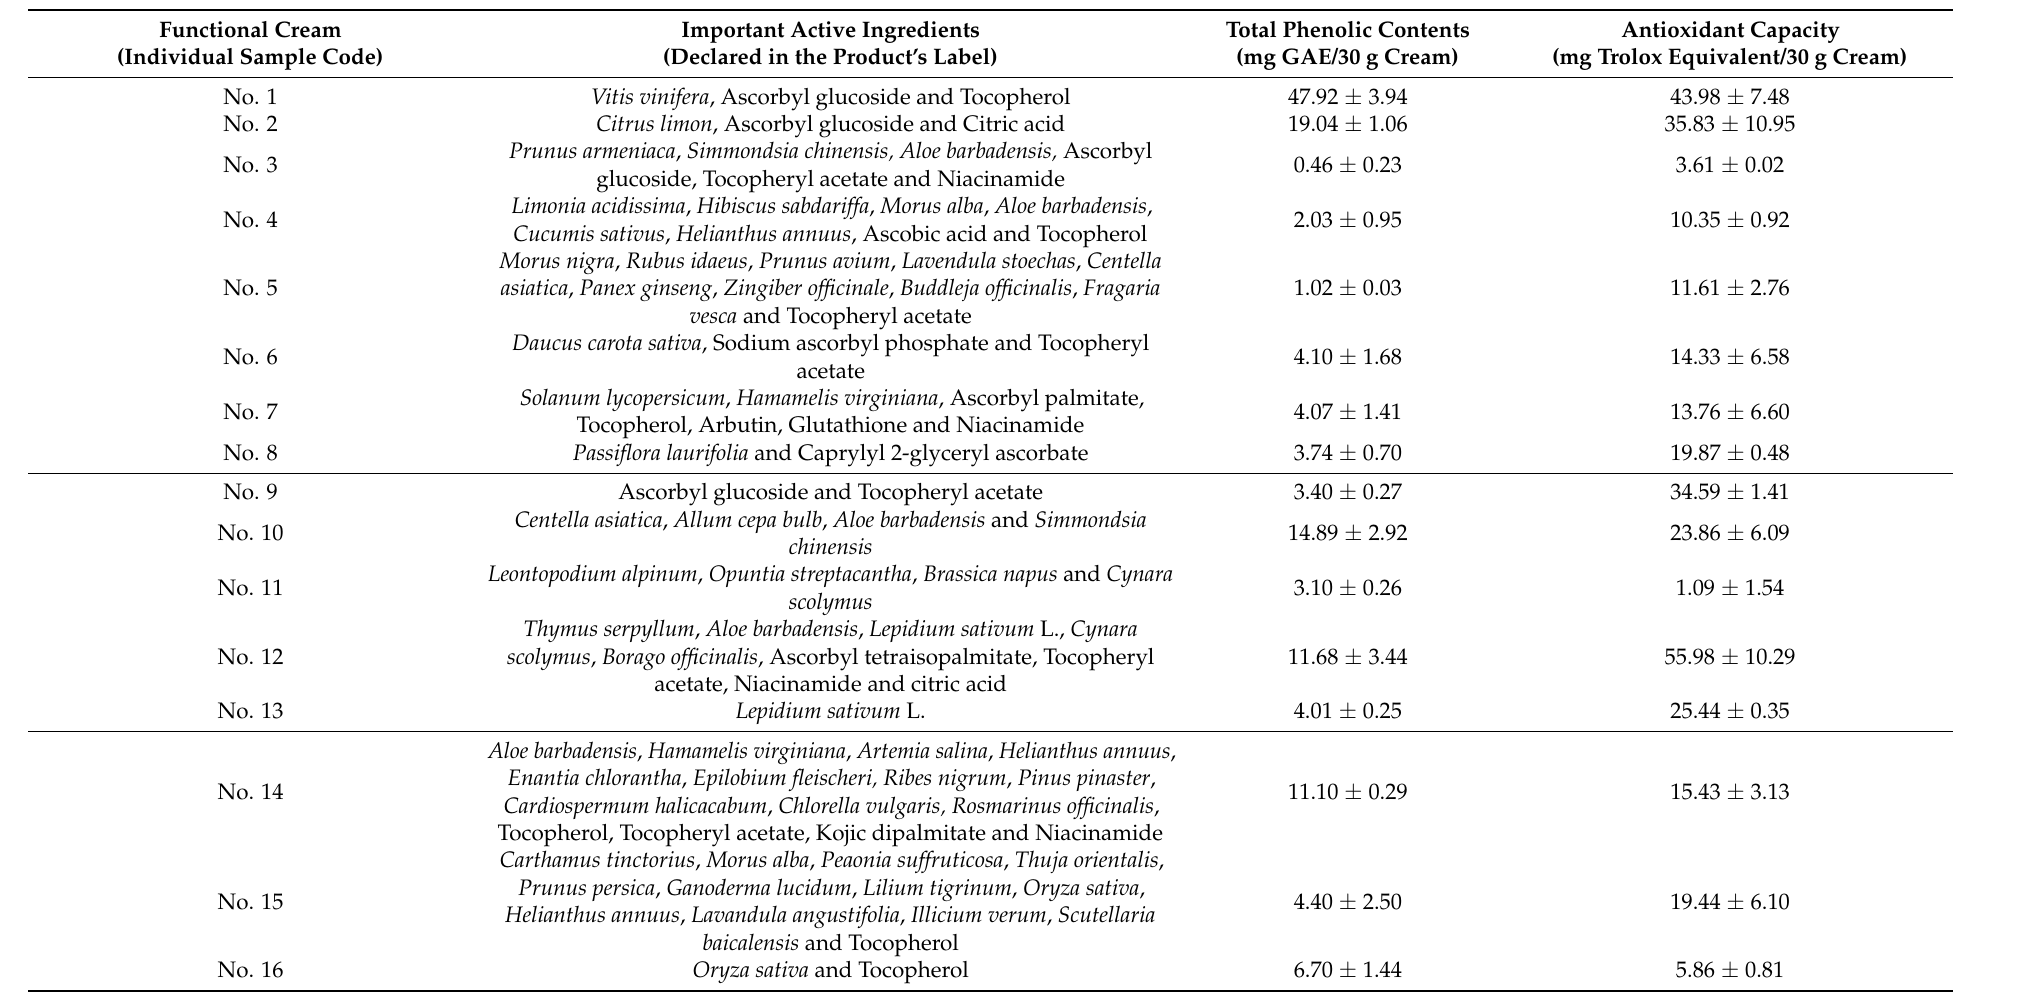
Table 1. Functional cosmetic cream samples obtained from the Thai market with their respective phenolic contents and antioxidant capacities (total number of samples = 23). Functional